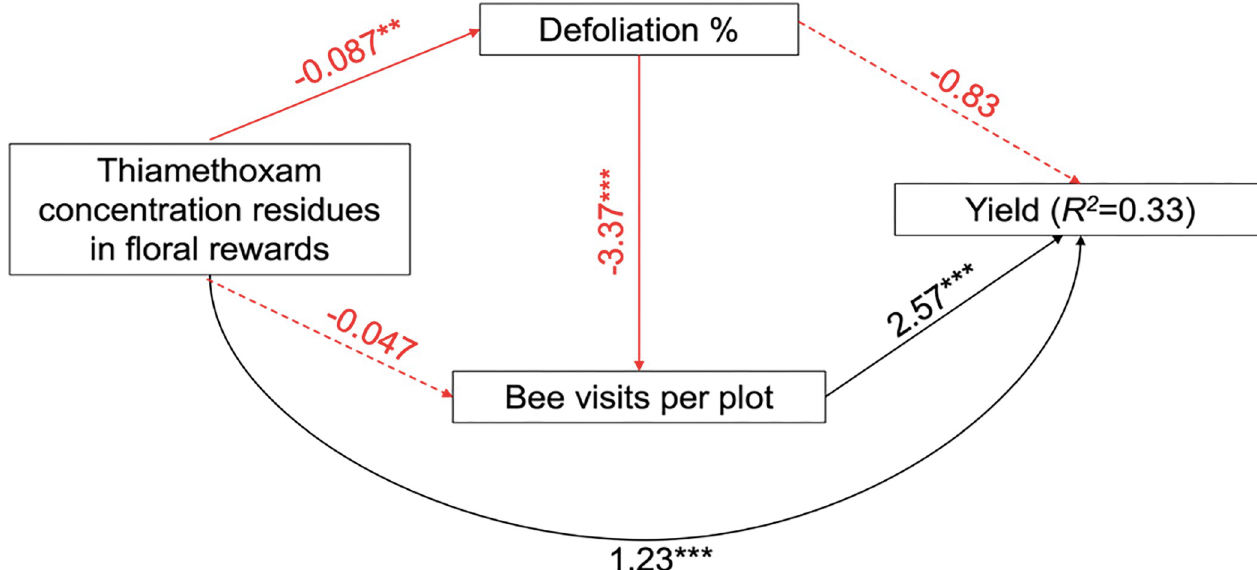
Fig 6. Path model for relationships between thiamethoxam concentration residues in pollen and nectar, defoliation, bee visits, and crop yield (Fisher’s C = 0.059, df = 2, P = 0.971) in both squash varieties. Solid lines indicate significant effects, while dashed lines denote nonsignificant effects. Black lines are positive effects, while red lines are negative effects. The number along the arrows are unstandardized path coefficients obtained from effect models, and stars demark the significance level ( � P < 0.05, �� P < 0.01, ��� P < 0.001).